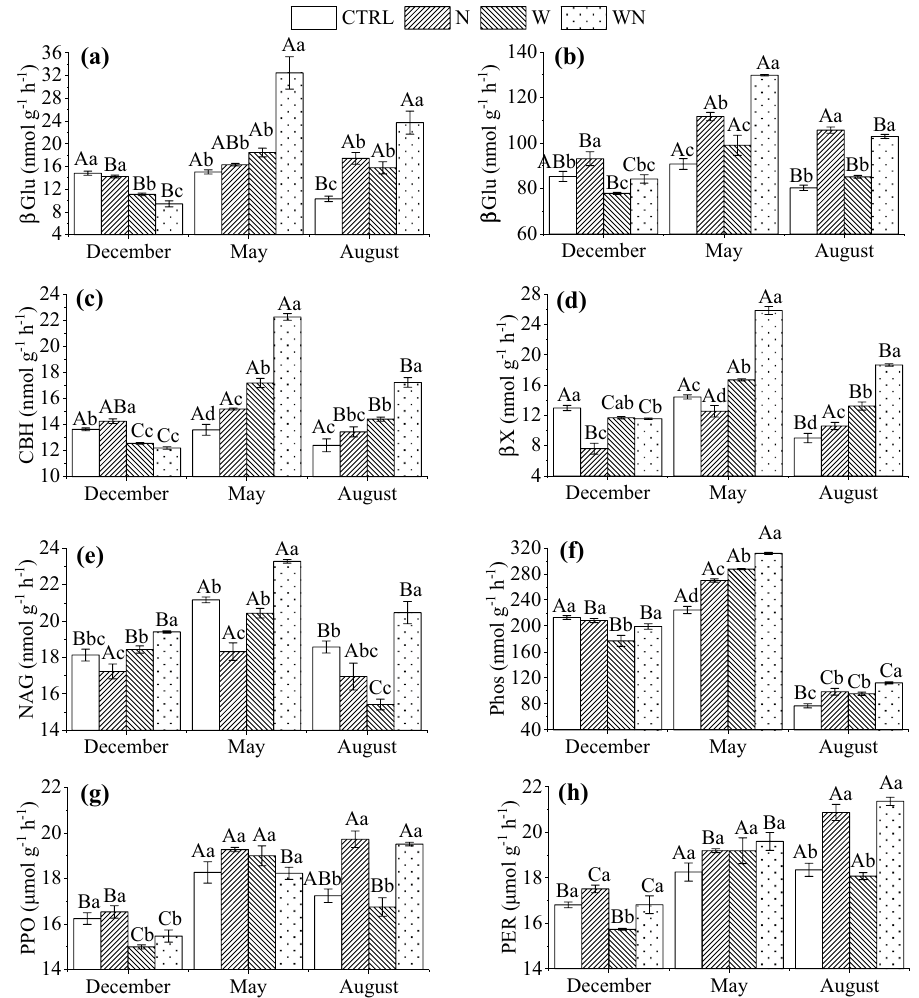
Figure 2. Effects of long-term warming (W), nitrogen fertilization (N) and their combination (WN) on soil C-, N-, and P-hydrolase and oxidase activities. αGlu and βGlu are, respectively, α- and β-1,4-glucosidase, CBH is cellobiohydrolase, βX is β-1,4-xylosidase, NAG is β-1,4- N -acetylglucosaminidase, Phos is alkaline phosphatase, PER and PPO are, respectively, per- and phenol